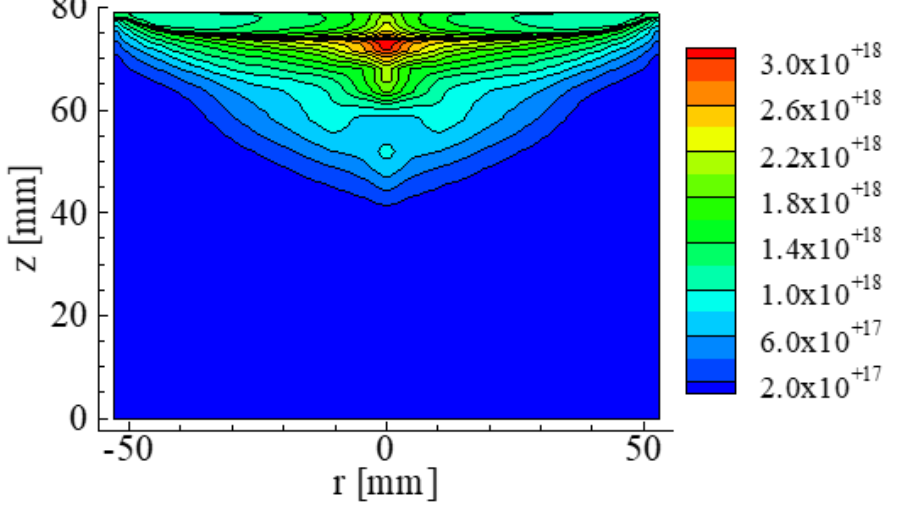
Figure 10. Concentration distribution of Si 3 N 4 in Si. The unit of concentration is atoms/cm 3 Reproduced using data from reference [17].